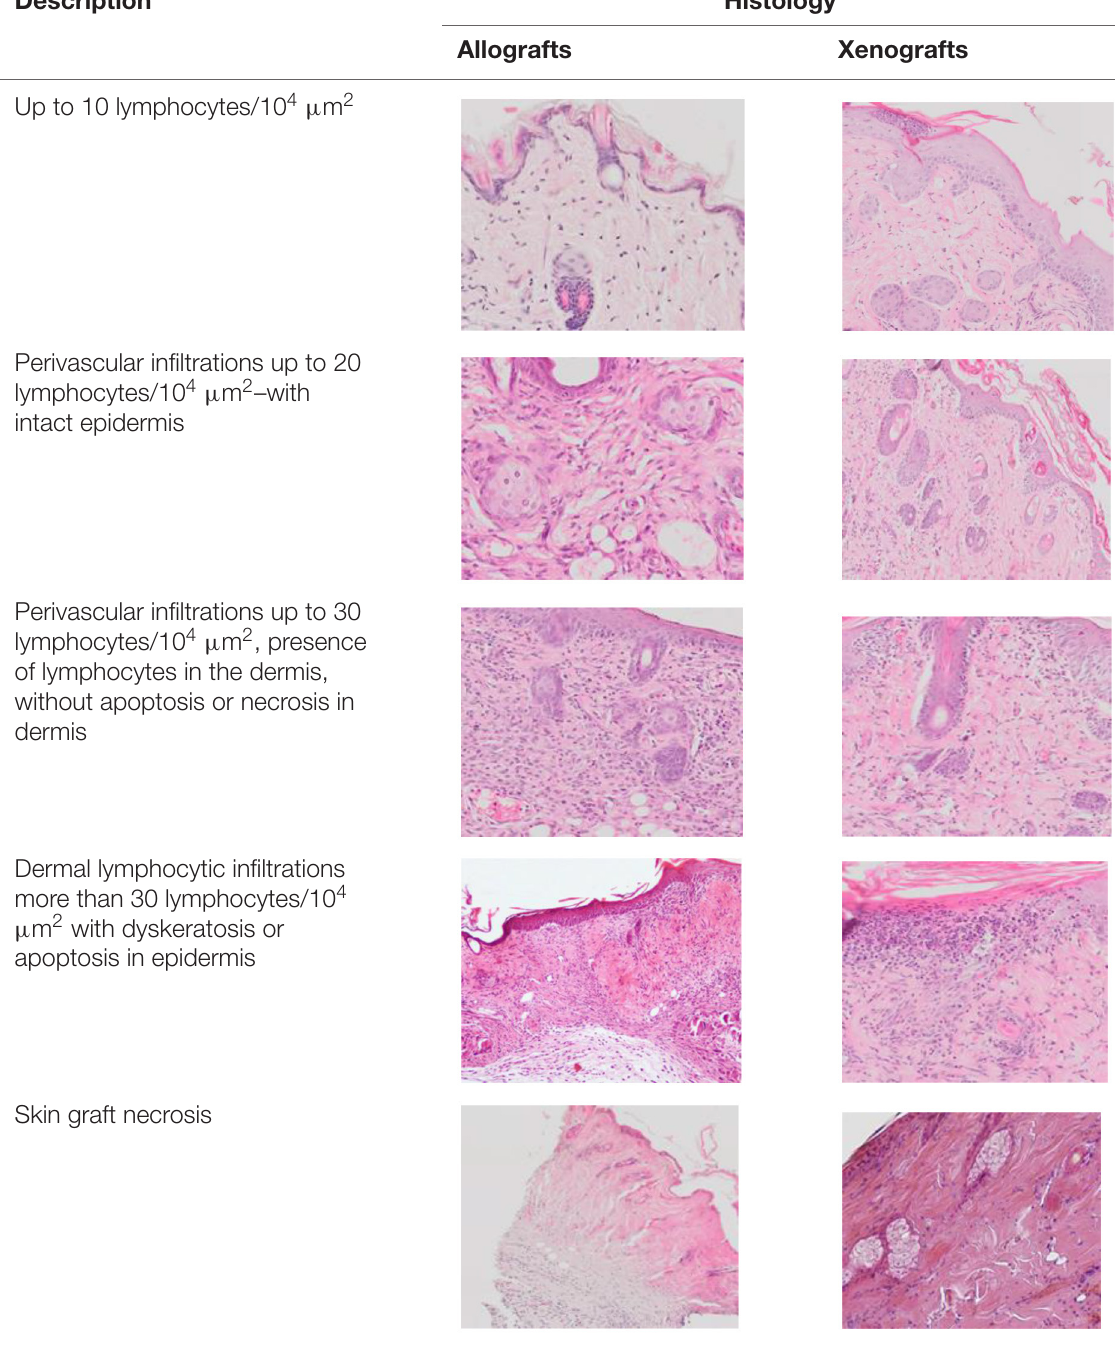
TABLE 2 | Scale of histologic stages of the skin allo- and xenografts rejection.